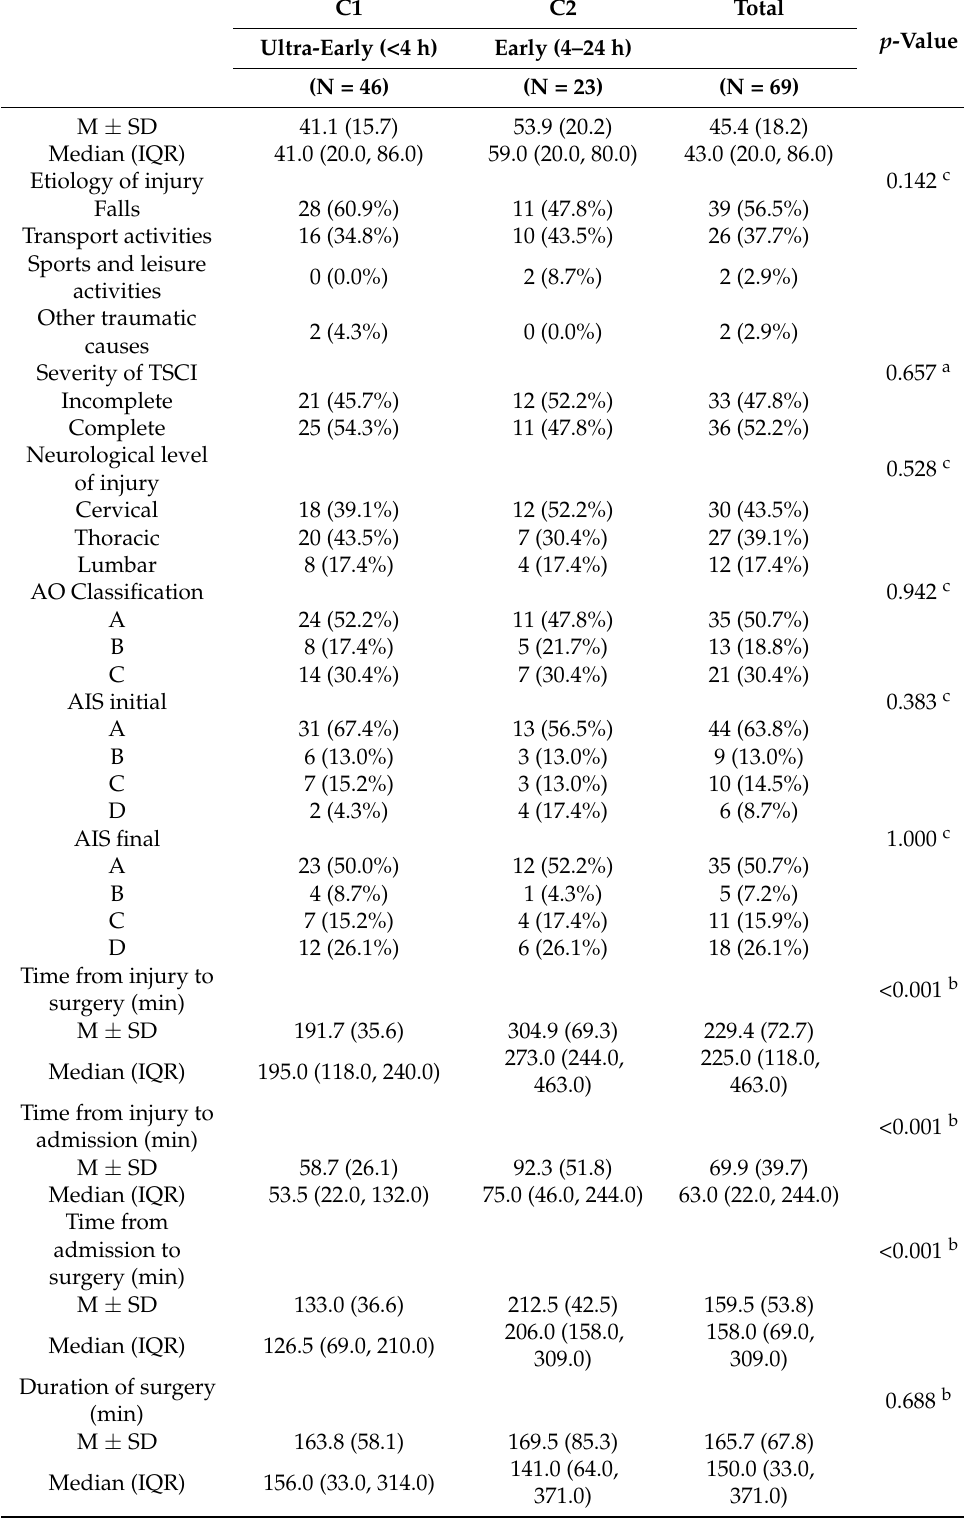
Table 2. Patient demographics of C1 and